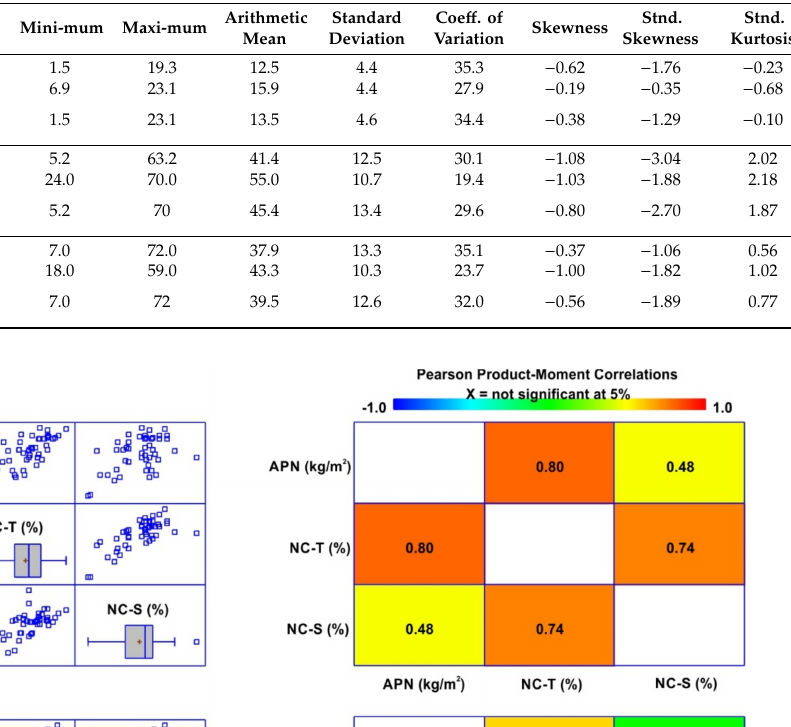
Table 1. Statistics of nodule abundance (APN) and nodule coverage of laboratory grid (NC-T) and seafloor (NC-S).